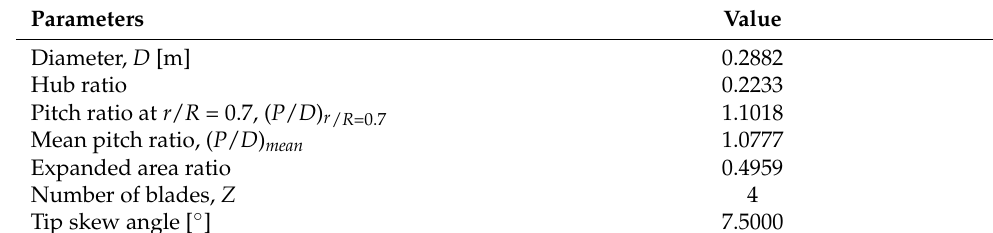
Table 1. Geometric details of test model.